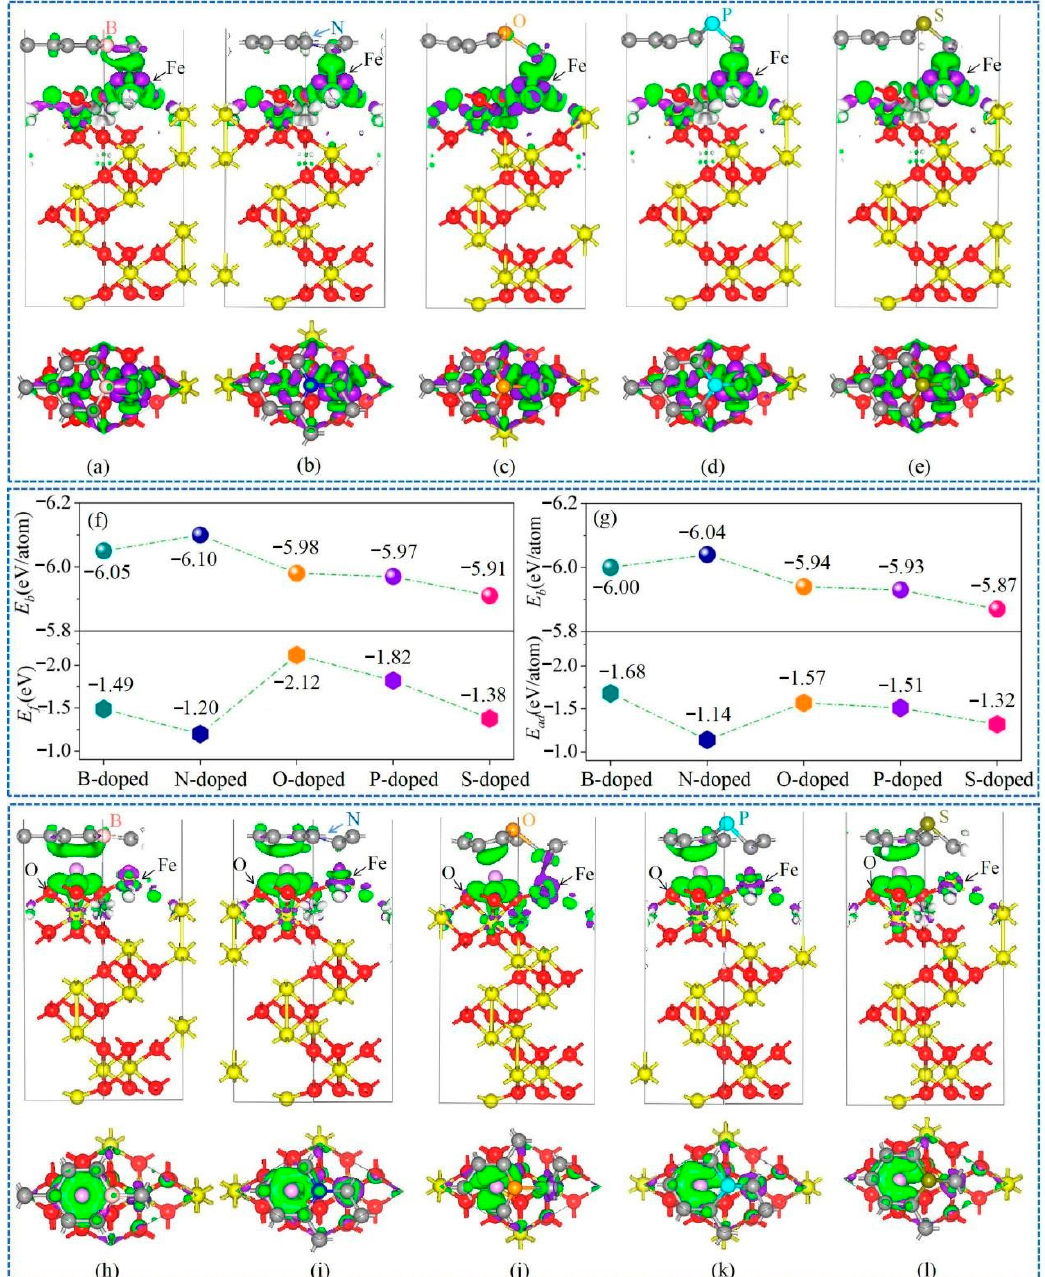
Figure 7. Charge difference plots for ( a – e ) M-doped Gr/Fe-O 3 -Fe-R systems (M = B, N, O, P, and S; isosurface level was set to 0.04 electrons/bohr 3 ); ( f ) binding energy ( E b ) and interfacial formation energy ( E f ) for ( f ) M-doped Gr/Fe-O 3 -Fe-R; ( g ) binding energy ( E b ) and adsorption energy ( E ad ) for Li adsorbed on M-doped Gr/Fe-O 3 -Fe-R systems; ( h – l ) charge difference plots for Li adsorbed on M-doped Gr/Fe-O 3 -Fe-R systems (isosurface was set to 0.02 electrons/bohr 3 ).